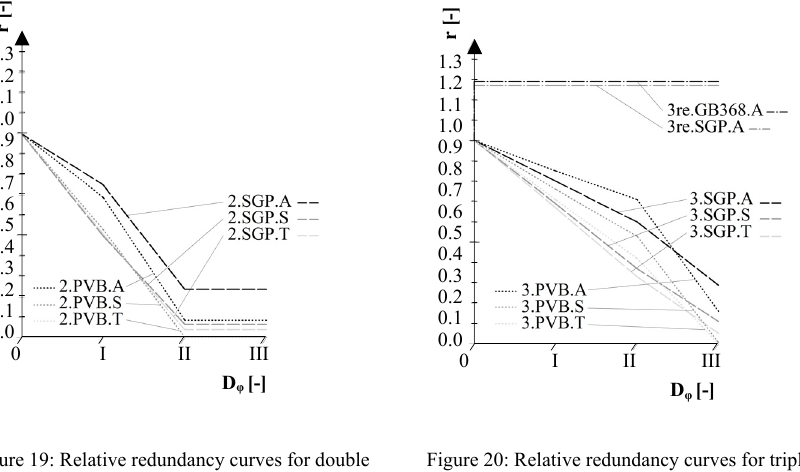
Figure 19: Relative redundancy curves for double layer glass beams.